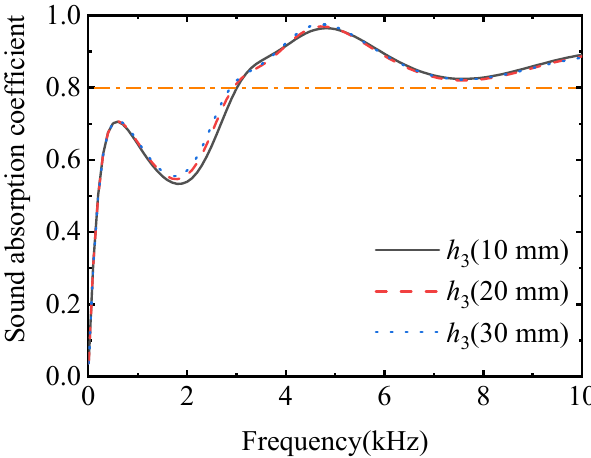
Figure 12. Comparison of α of SSC-CO corresponding to different cylinder heights.